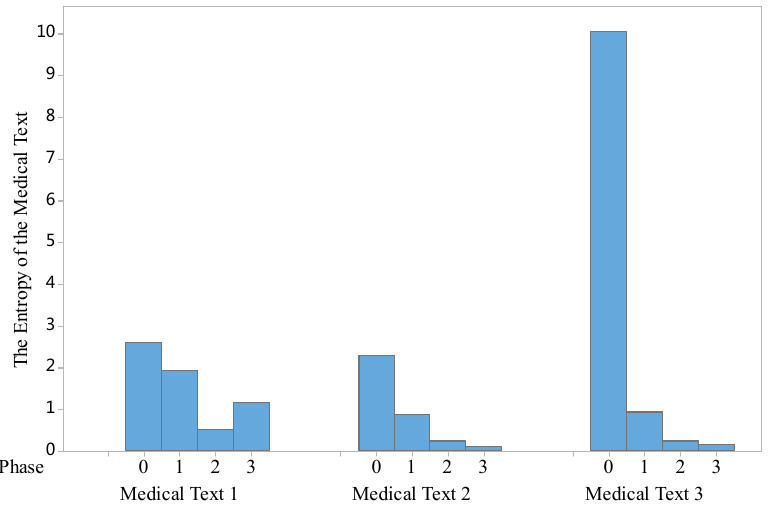
Figure 4. The changes of entropy in four phases (three selected EMR text samples).